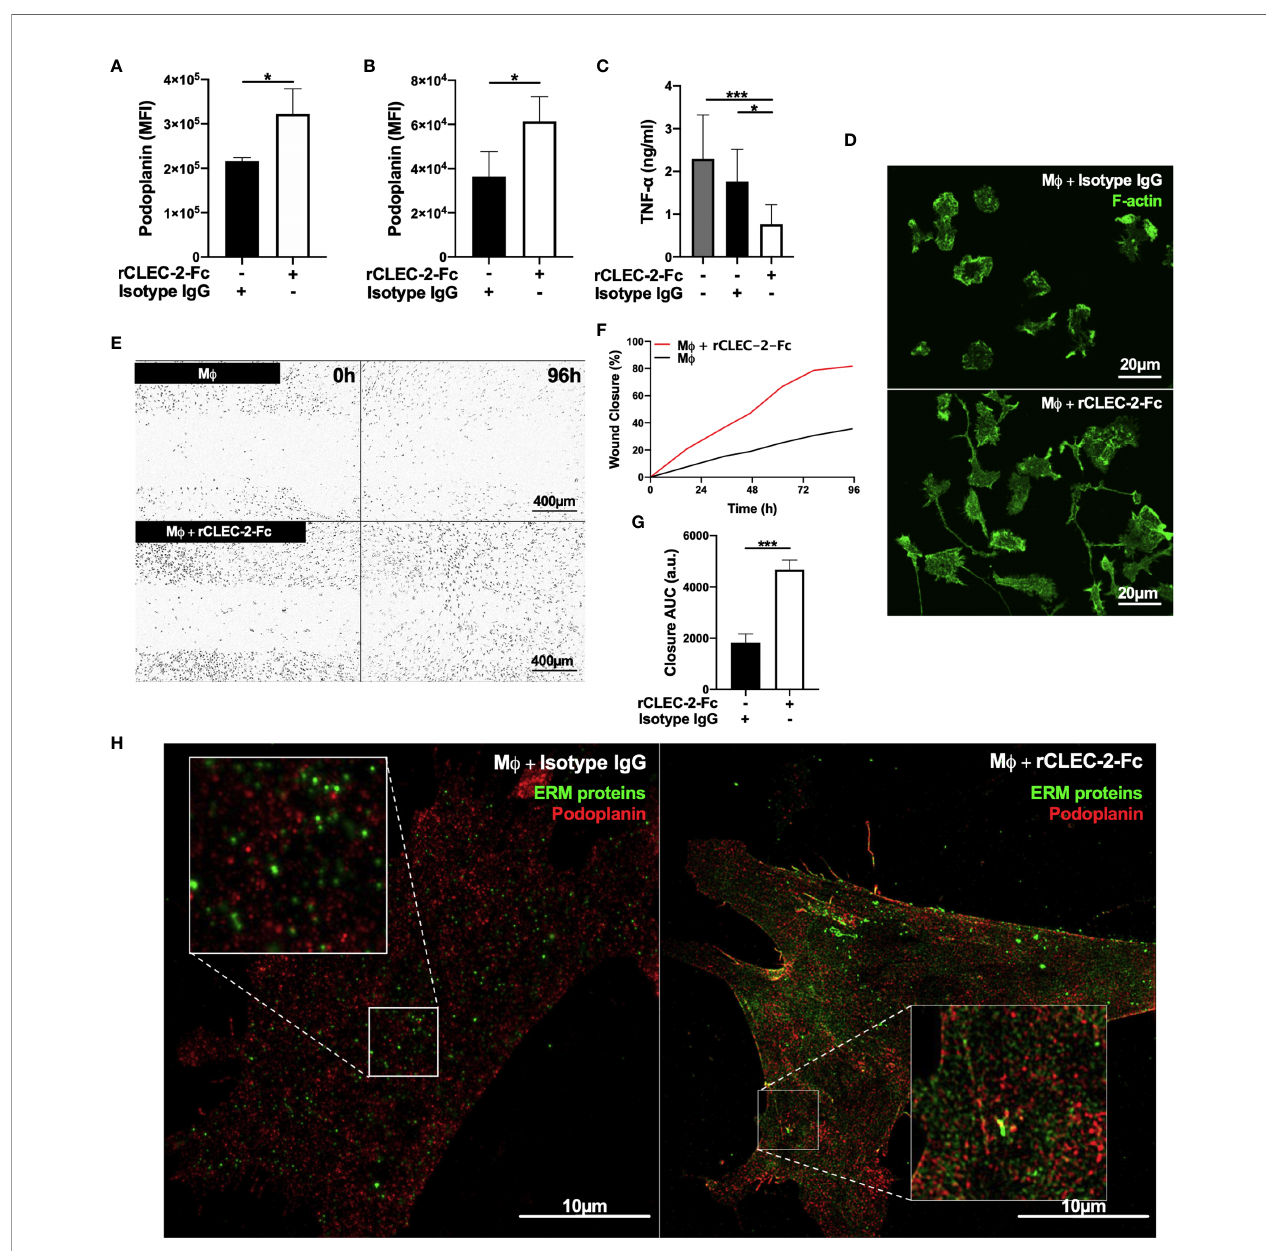
FIGURE 3 | rCLEC-2-Fc upregulates podoplanin expression, and promotes macrophage spreading and migration in vitro. (A, B) Surface podoplanin expression was detected by fl ow cytometry using a conjugated anti-podoplanin antibody. 24h LPS-stimulated (1µg/ml) (A) RAW264.7 cells (n=3) or (B) BMDM (M f ; n=4), were washed and incubated with recombinant CLEC-2-Fc (rCLEC-2-Fc; 10µg/ml) or IgG isotype control (10µg/ml) for 1h. (C) M f were washed, and cultured with rCLEC-2-Fc (10µg/ml) or IgG isotype control (10µg/ml) for 2h before TNF- a secretion was quanti fi ed in the media supernatant by ELISA (n=4). (D) LifeAct-GFP-derived M f were spread on collagen in the presence of rCLEC-2-Fc or IgG isotype control (10µg/ml) for 2h and measured with immuno fl uorescence by confocal microscopy. (E – G) Scratch wound migration of M f was monitored every 2h for a total of 96h using an Incucyte ZOOM system. Following wound scratch, (E) rCLEC-2-Fc (10µg/ml) was added to M f . (F) Wound closure was quanti fi ed as percentage of closure compared to initial scratch size using ImageJ. (G) Total wound closure was quanti fi ed using area under the curve (AUC) at 96h (a.u.= arbitrary units; n=3). (H) M f were cultured on collagen in the presence of rCLEC-2-Fc or IgG isotype control (10µg/ml) for 2h. Podoplanin (red) and ERM protein (green) localisation was visualised using immuno fl uorescence by 3D-structured illumination microscopy (3D-SIM). The statistical signi fi cance between 2 groups was analyzed using a student ’ s paired t-test and the statistical difference between multiple groups using one-way ANOVA with Tukey ’ s multiple comparisons test. * p < 0.05 *** p <